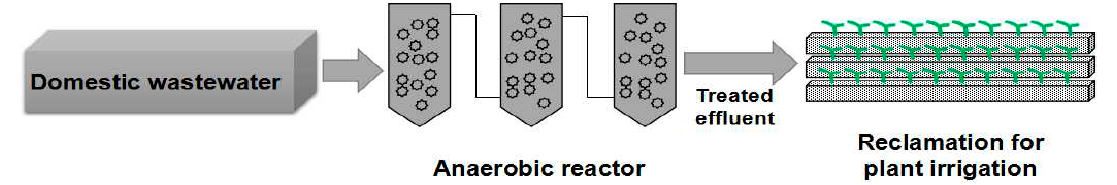
Figure 1. Schematic diagram of domestic wastewater from processing to recycling.